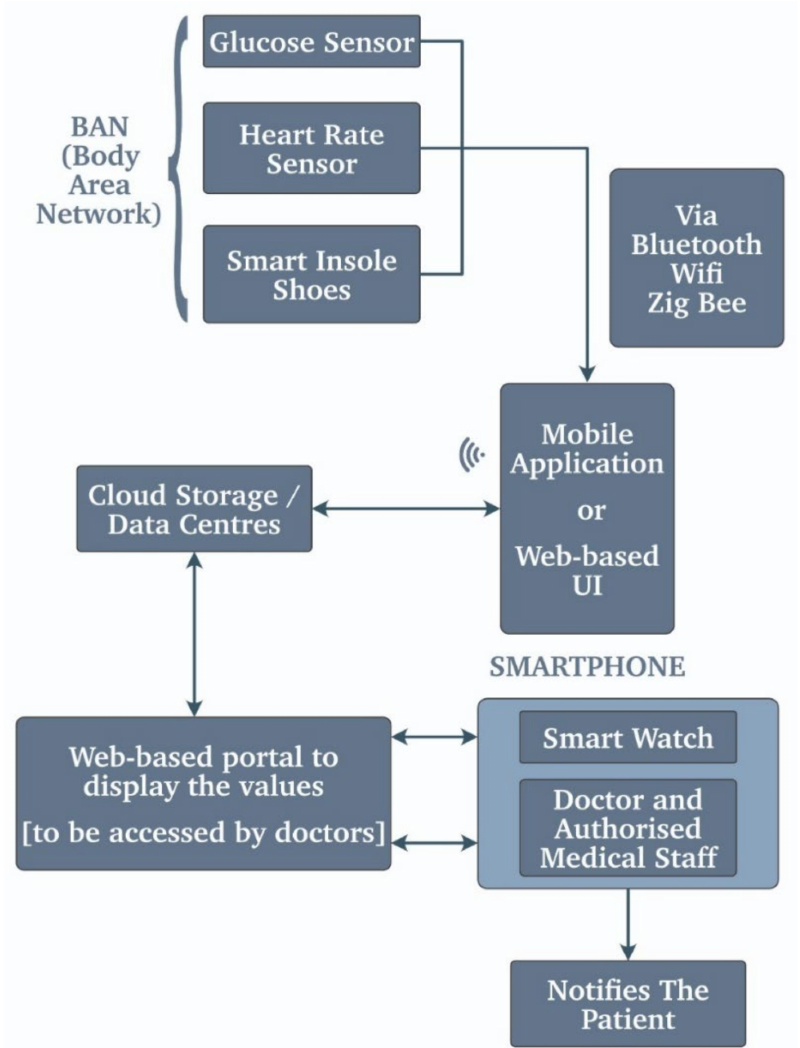
Figure 8. Blood glucose monitoring